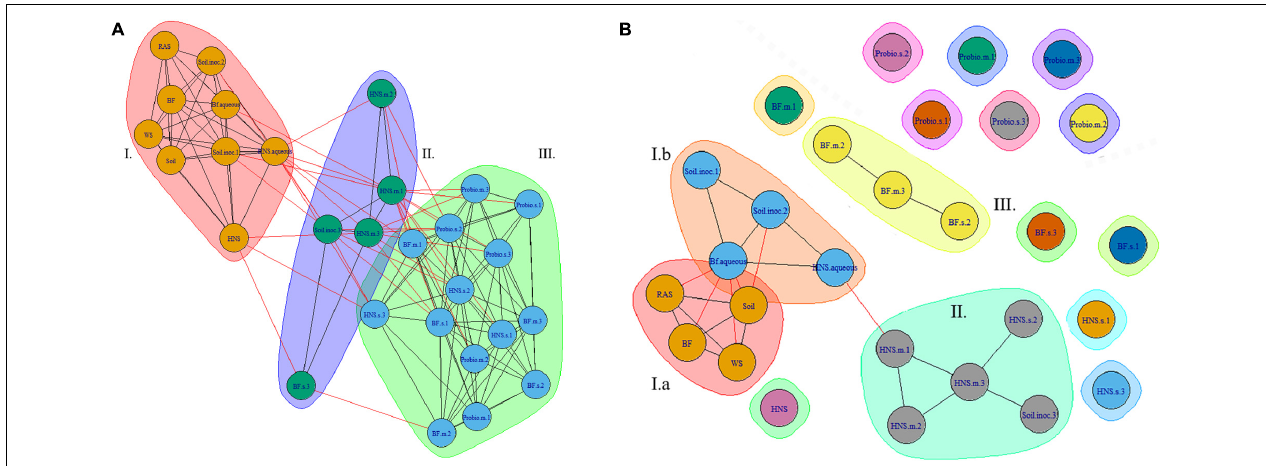
FIGURE 5 | Co-occurrence network of microbial communities across treatments at the class (A) and family (B) ranks. Treatments include hydroponic nutrient solution sump (HNS) and biofilter effluent sump (BF) under mature (.m), sterilized (.s), and basin water column (.aqueous) conditions. Additionally, soil inoculum (Soil) and HNS inoculated culture (soil) and probiotic (probio) inoculated sterilized (.s) and unsterilized biofilter effluent (BF) samples, as well as the facility water source (WS) and recirculating aquaculture system water column (RAS) are also